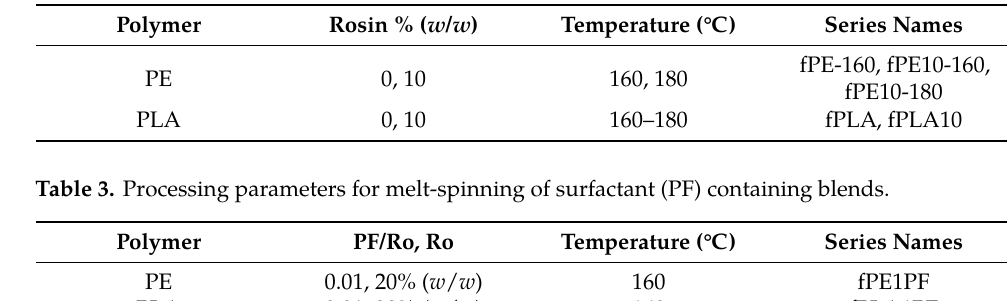
Table 2. Processing parameters for melt-spinning of rosin-containing blends.